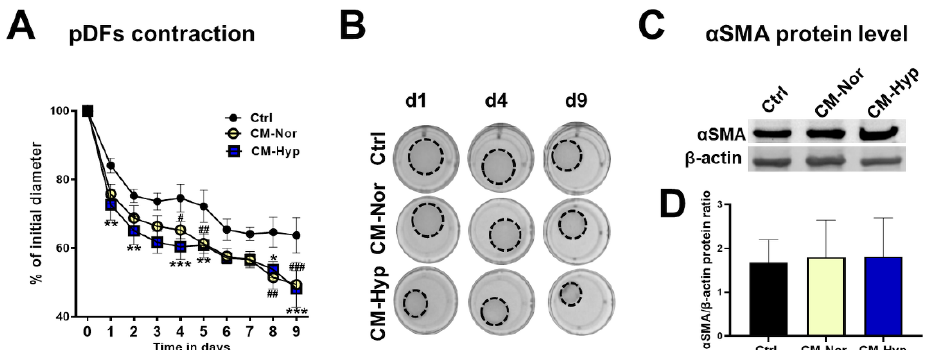
Figure 4. Contractile abilities of pDFs exposed to pASC-CMs. ( A ) Both CM-Nor and CM-Hyp increased pDFs capacity to contract collagen lattices as compared to control cultures. ( B ) Represen- tative images show pDFs contractile abilities in CM-Nor, CM-Hyp, and control medium at days 1, 4, and 9. ( C ) Western blot and ( D ) densitometry analysis of total α SMA protein content detected in DFs exposed to CMs. The results are shown as the mean ± SD. The asterisks indicate signifi- cant differences between CM-Hyp treated and control cultures (* p < 0.05; ** p < 0.01; *** p < 0.001). Hashes show significant differences between CM-Nor exposed cells and control ( # p < 0.05; ## p < 0.01; ### p < 0.001). Abbreviations: pASCs, pig adipose-derived stem cell; pDFs, pig dermal fibroblasts; CM-Nor, conditioned medium collected from pASCs exposed to normoxia; CM-Hyp, conditioned medium collected from pASCs cultured under hypoxia; α SMA, smooth muscle actin